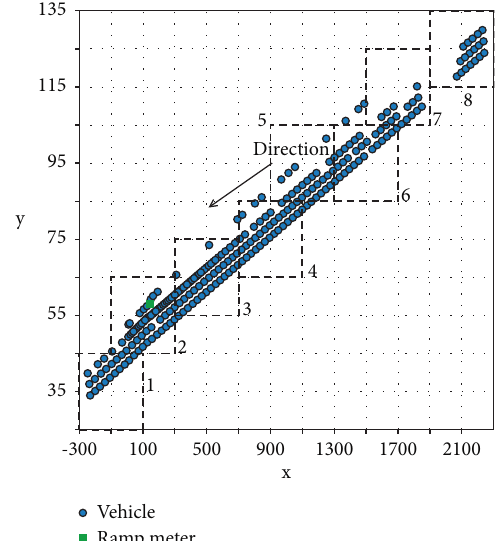
Figure 15: Division subareas.